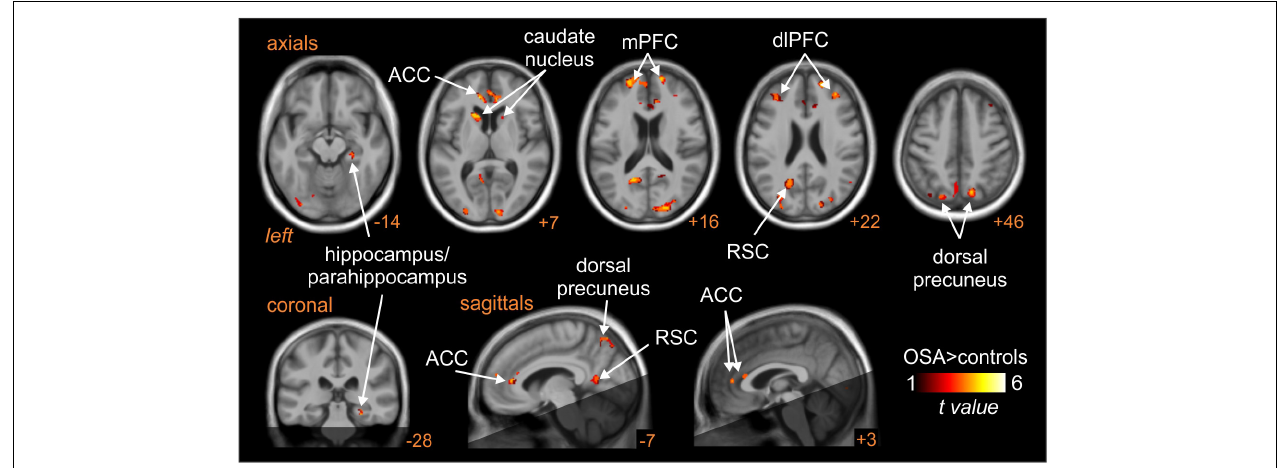
FIGURE 8 | Brain regions in which MSNA-coupled changes in BOLD signal intensity were significantly different in OSA than controls. The dark shading indicates brain regions not included in the analysis. ACC, anterior cingulate cortex; dlPFC, dorsolateral prefrontal cortex; mPFC, medial prefrontal cortex; RSC, retrosplenial cortex. Reproduced, with permission, from Fatouleh et al. (2014).